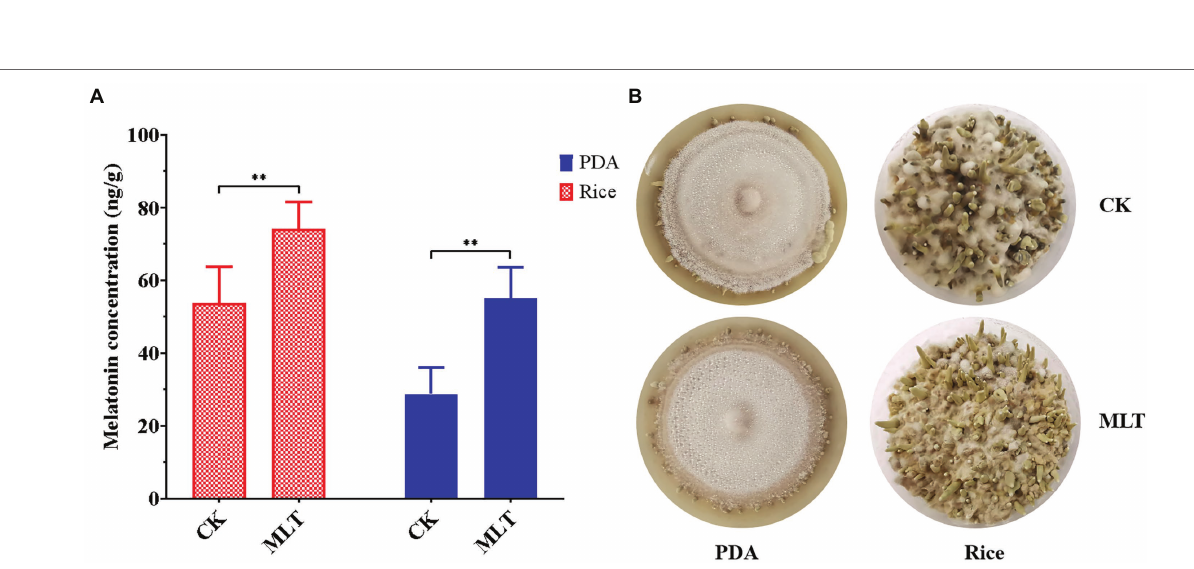
FIGURE 6 | Effect of exogenous melatonin on the primordial formation in T. guangdongense . (A) Primordial numbers of T. guangdongense on PDA and rice medium, respectively. (B) Primordial characteristics of T. guangdongense on PDA and rice medium. CK, group untreated by melatonin; MLT, group treated by 10 μ M melatonin. **, highly significant differences ( p <